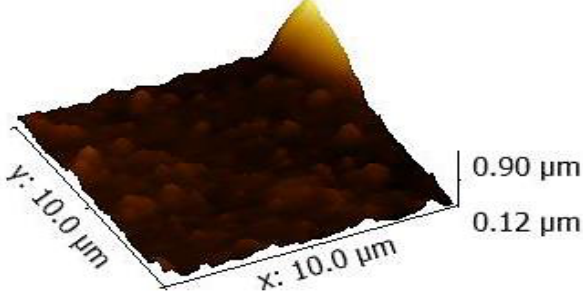
Figure 7. AFM image of CIIR-CB (20)-CNT (5), the best result for EMI shielding of 59